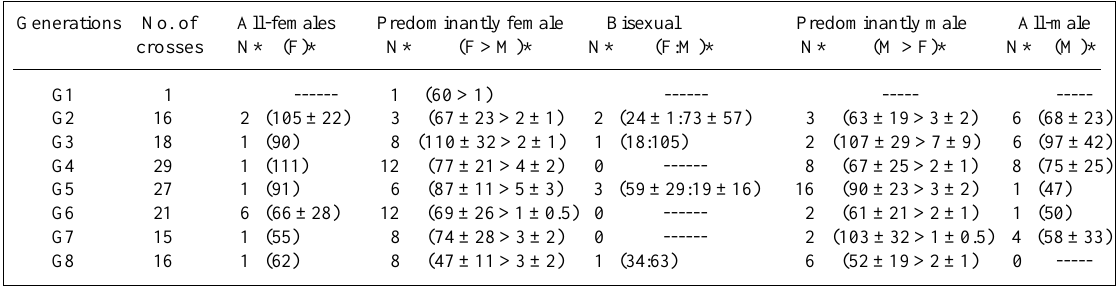
Table I - Progeny classes and number of individuals per progeny produced by B. matogrossensis females in eight generations. Generations No.